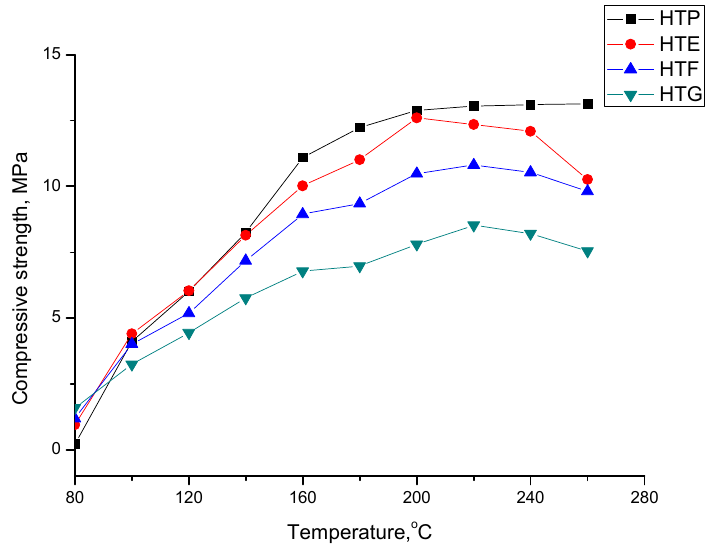
Figure 8. Consolidation performance of HTP at different temperature levels.